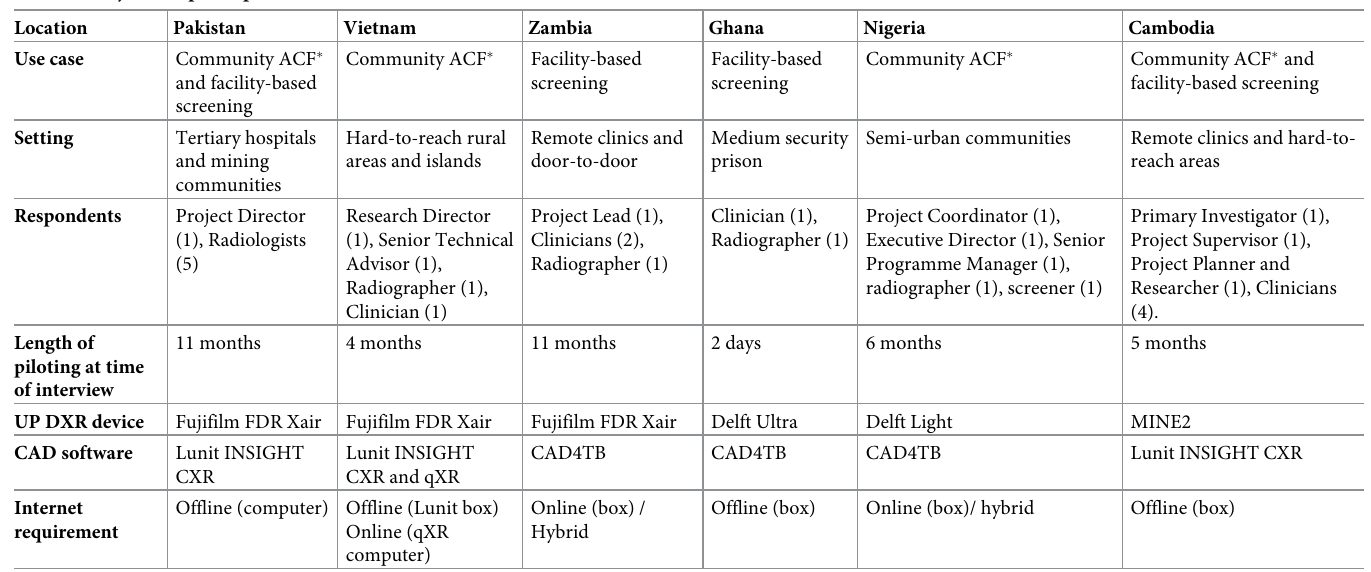
Table 1. Project and participant